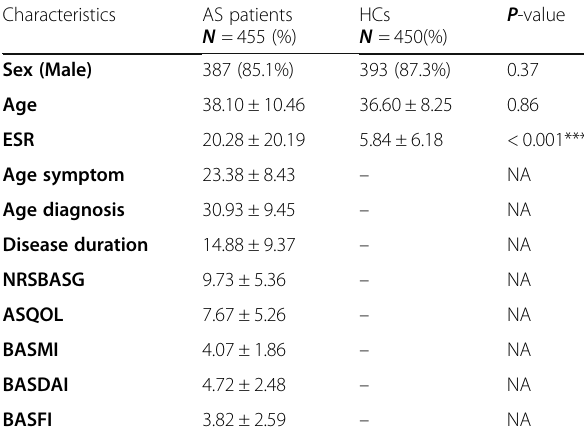
Table 1 Demographic data and clinical features of AS patients and healthy controls recruited in this study Characteristics